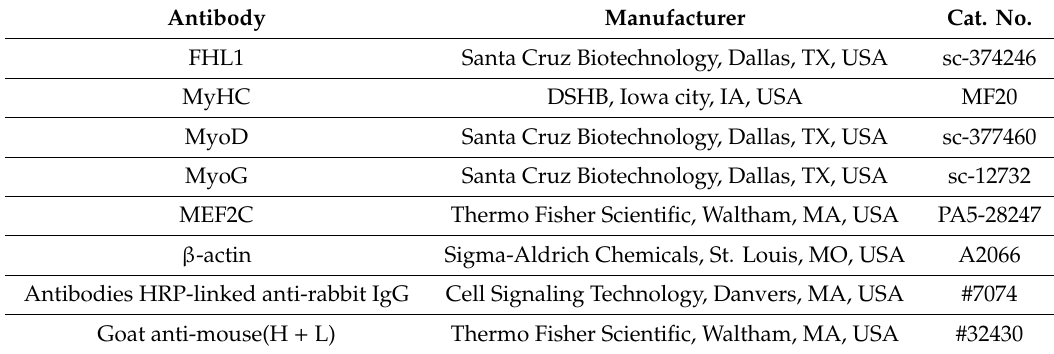
Table 2. Antibodies